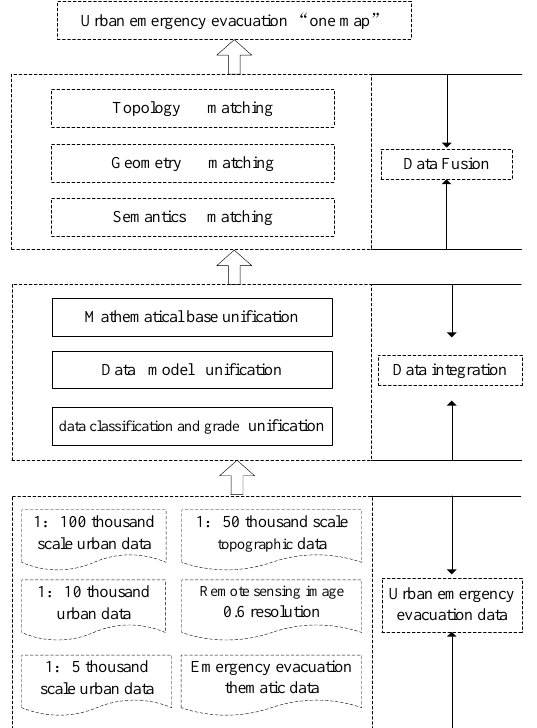
Figure 1 Frame of urban emergency evacuation